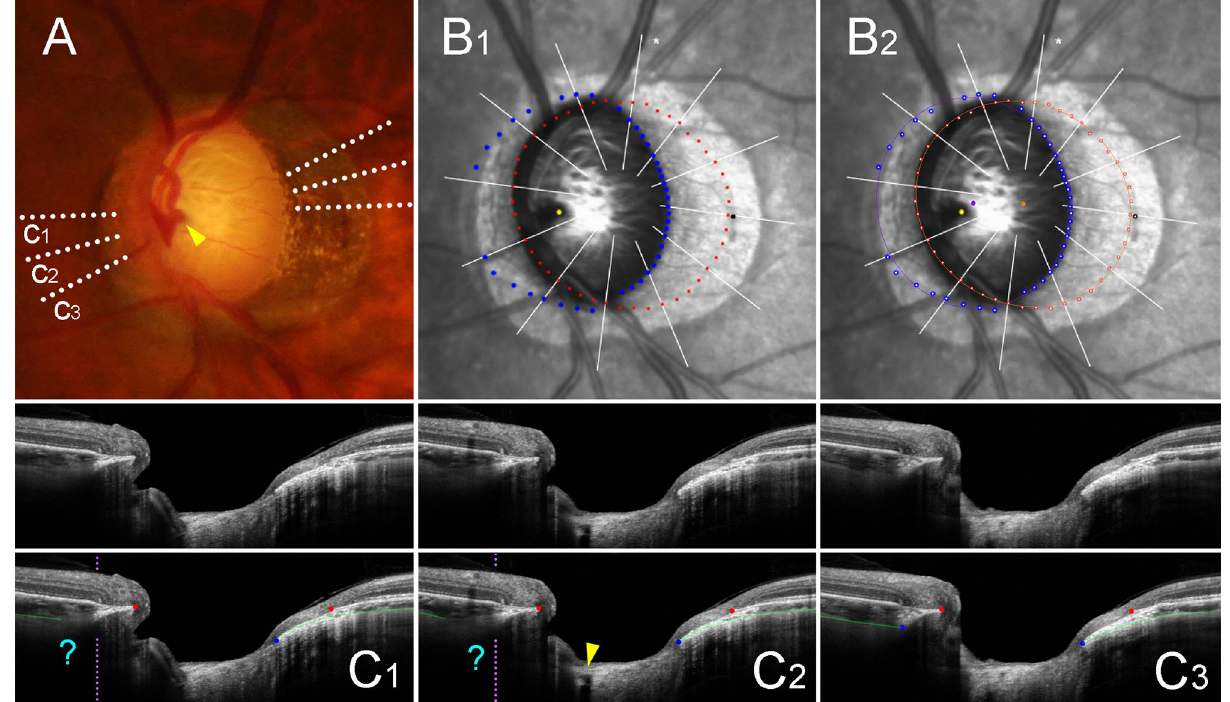
Figure 3. Sample case of outer-wall shift to nasal side (left eye of 47-year-old man with glaucoma, axial length of 26.68 mm). ( A ) Disc photograph. The arrowhead indicates the location of the central retinal vascular trunk (CRVT). The dotted lines indicate the location of the OCT scan. ( B ) Infrared images. ( B 1 ) Bruch’s membrane opening (BMO, red dots), anterior scleral opening (ASCO, blue dots), CRVT position (yellow dot), and meridian of longest externally oblique border (EOB, black dot) are marked. ( B 2 ) Best-fitted ellipses for BMO (orange ellipse) and ASCO (purple ellipse) are drawn with their centers (orange dot for BMO center, purple dot for ASCO center). ( C ) B-scan OCT images (top row: original images, bottom row: images with labels). The red dots indicate the BMO margin; the blue dots indicate the ASCO margin; the green lines indicate the anterior scleral surface; the arrowhead indicates the CRVT. On the nasal side, the ASCO margin cannot be drawn ( C 1 , C 2 , question mark). The ASCO margin can be drawn on the adjacent scan ( C 3 ). Since the indiscernible angle is larger than 30° on the nasal side, this eye is classified as incomplete demarcation for ASCO and grouped accordingly. Despite the incomplete ASCO demarcation, the best-fitted ellipse could be fitted, and the boundary according to the fitting is marked by the purple dotted lines ( C 1 , C 2 ). Please note that both the CRVT and ASCO offsets are headed nasally, while the extent is larger for the CRVT offset than for the ASCO analyzed separately. Multiple regression analysis revealed that the angular deviation of the CRVT offset ( P < 0.001) and that of the ASCO offset ( P = 0.015) were both associated with the offset ratio (Table 2). The angular deviation of ASCO offset also showed significant correlations with that of the longest EOB ( r = − 0.933, P < 0.001). If we compared the absolute value of correlation coefficient to handle the opposite direc- tion of reference meridian (the nasal horizontal midline was set to zero for the ASCO and CRVT offsets, while the temporal horizontal midline was set to zero for the longest EOB), the angular deviation of ASCO offset showed more correlation with that of the longest EOB than that of CRVT offset ( P < 0.001, Williams’ test) 27 . In contrast to the angular deviations of the longest EOB and the CRVT offset, that of ASCO offset was rarely shifted to the inferior side (Fig. 2D). The multiple regression analysis revealed that the axial length ( P = 0.003), the angular deviation of the CRVT offset ( P = 0.002), and the meridian of the longest EOB ( P < 0.001) were associated with the angular deviation of ASCO offset (Table 3). The association with the meridian of the longest EOB remained significant in the control, glaucoma, and myopia groups when analyzed separately (Supplemental Table 2). The eyes were classified according to the completeness of ASCO demarcation: (1) group 1, complete demar- cation (85 eyes) and (2) group 2, incomplete demarcation (21 eyes; Table 1). This grouping showed excellent inter-observer reproducibility [Kappa statistic = 0.872 (95% confidence interval 0.748–0.997)]. Group 2 was of younger age and had a longer axial length, a larger BMO area, and a larger shift index relative to group 1 (Table 1). The logistic regression analysis revealed that incomplete demarcation of ASCO margin (group 2) was associated with larger BMO area ( P = 0.036) and larger shift index ( P < 0.001; Table 4). Larger shift index was also associated with incomplete ASCO demarcation in the control, glaucoma, and myopia groups when analyzed separately (Supplemental Table 3).